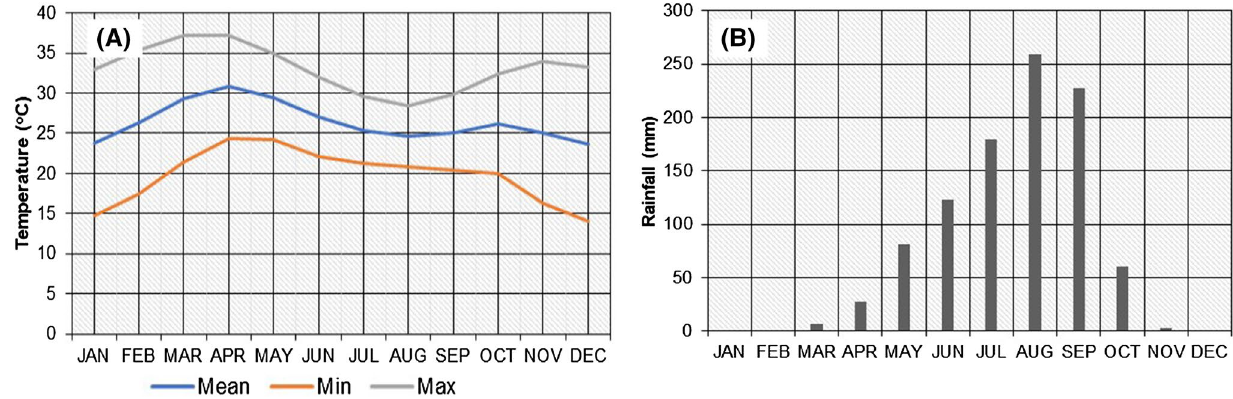
Fig. 2 A chart showing the variability of a temperature; and b rainfall in the study area. Source of Data : Climate-Data Org. Retrieved from https ://en.clima te-data.org/afric a/niger ia/kebbi /zuru-38058 0/on